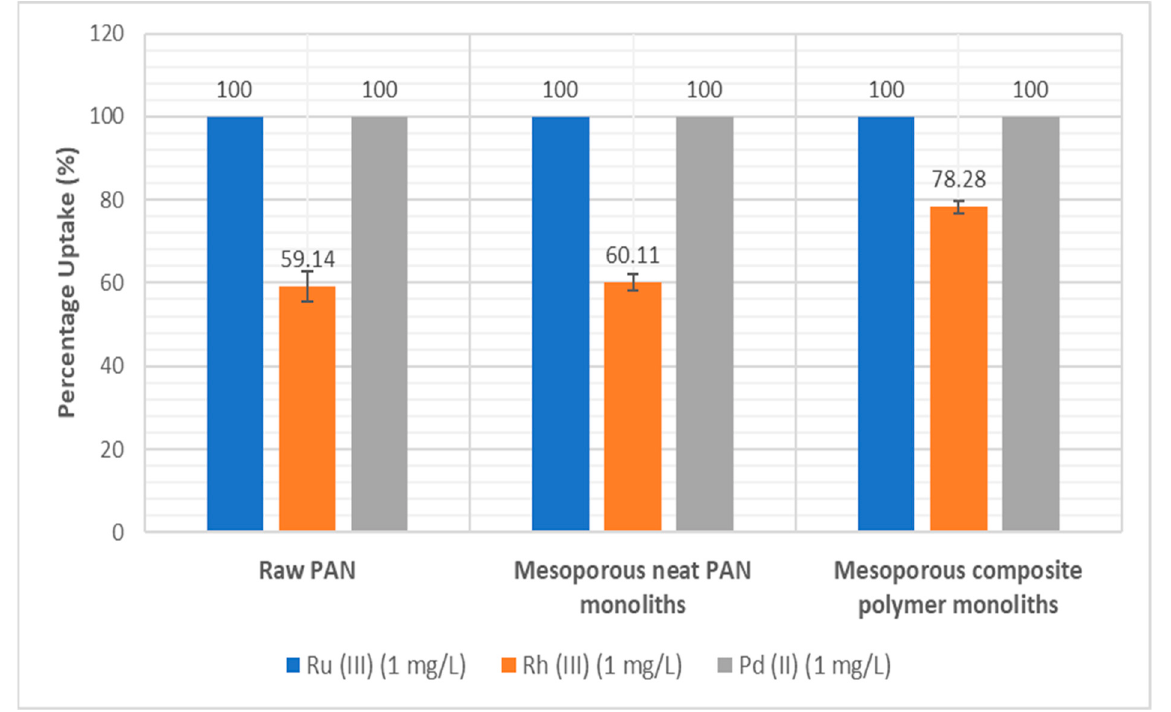
Figure 9. The percentage recovery of each of the three PGMs (Ru(III), Rh(III), Pd(II)) from 1 mg·L − 1 prepared standard solutions by the three different polymer materials with error bars included.